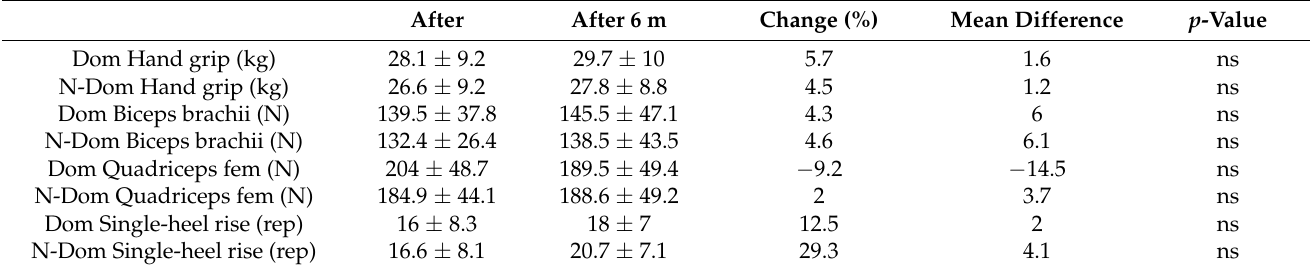
Table 3. Comparison of muscle function after training and at the 6-month follow-up ( n = 15). After After 6 m Change (%) Mean Difference p -Value 28.1 ±